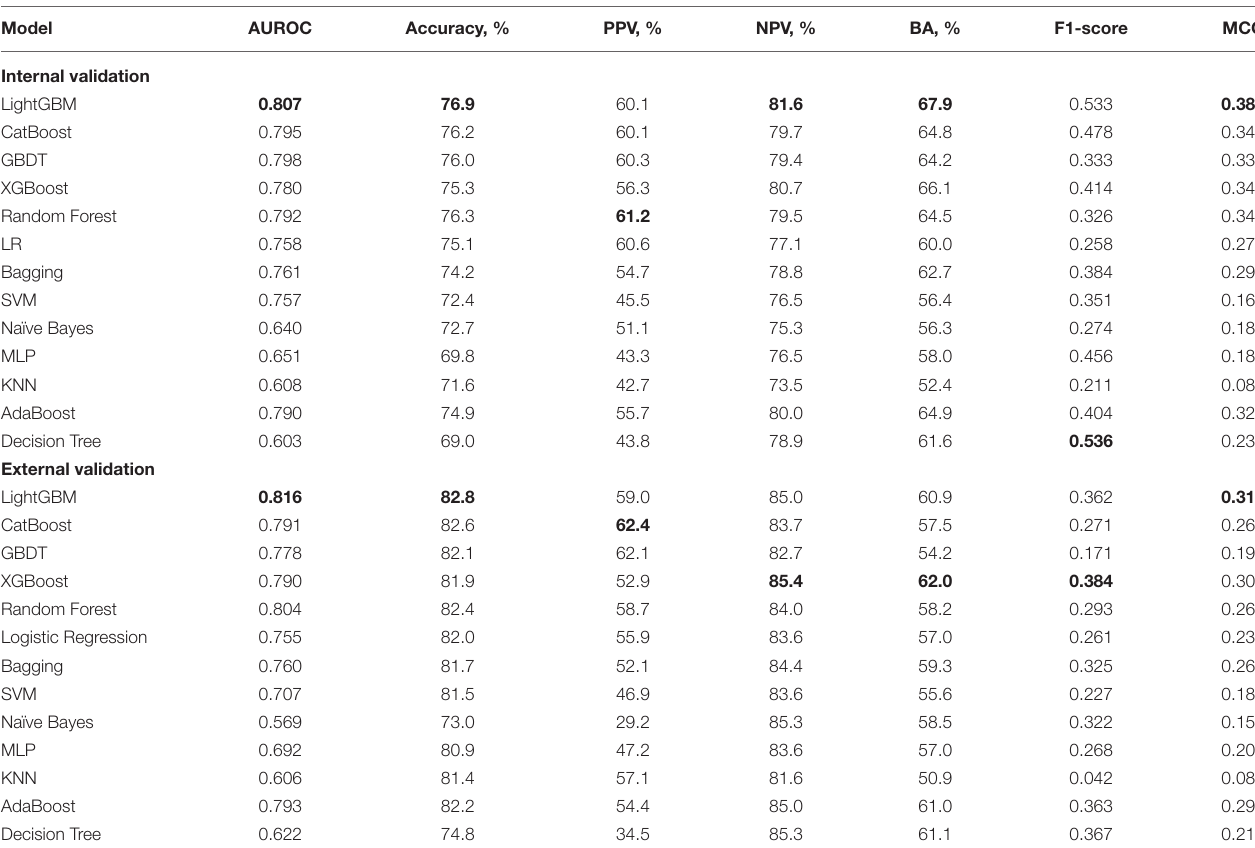
TABLE 2 | Model evaluation.